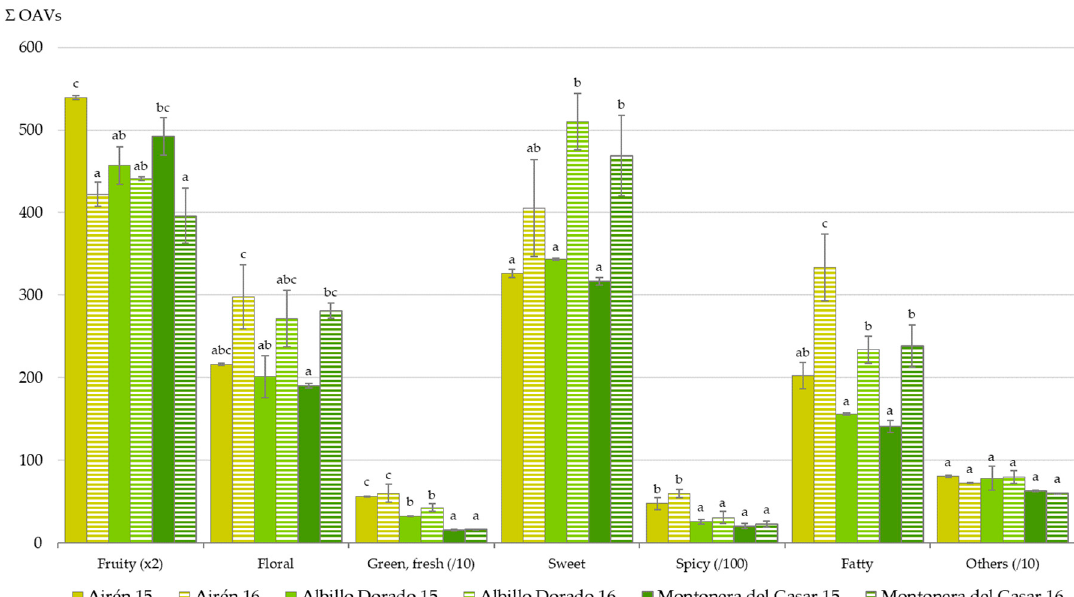
Figure 1. Aromatic series ( Σ OAVs, mean value ± standard deviation, n = 2) in white wines made from Airén and the novel grape genotypes at two consecutive years (2015 and 2016). Different letters in the same aromatic series indicate that the values are significantly different among the wines (ANOVA, Student–Newman–Keuls test, p < 0.05).